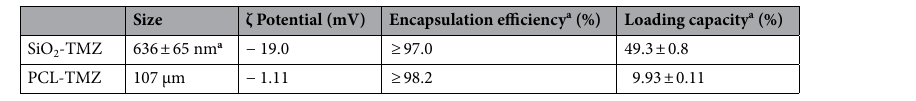
Table 1. Characterization of TMZ-loaded microcarriers. a Data expressed as mean ±